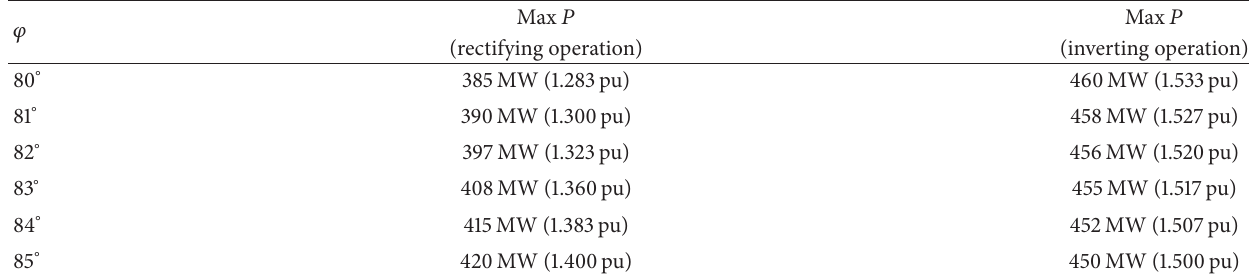
Table 7: Limits of power transmission with different 𝜑